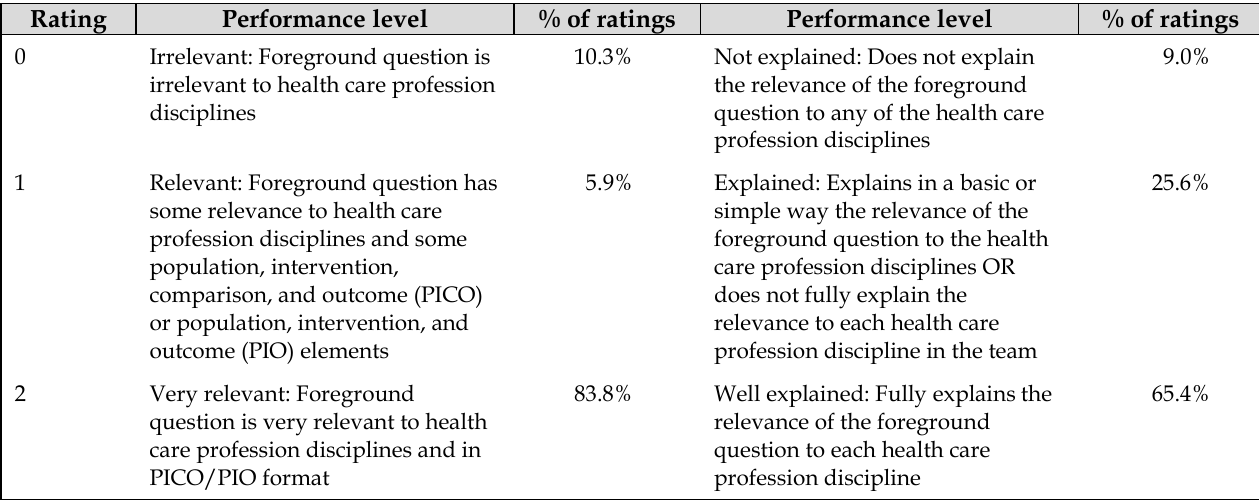
Table 2 Ratings for foreground questions on student posters